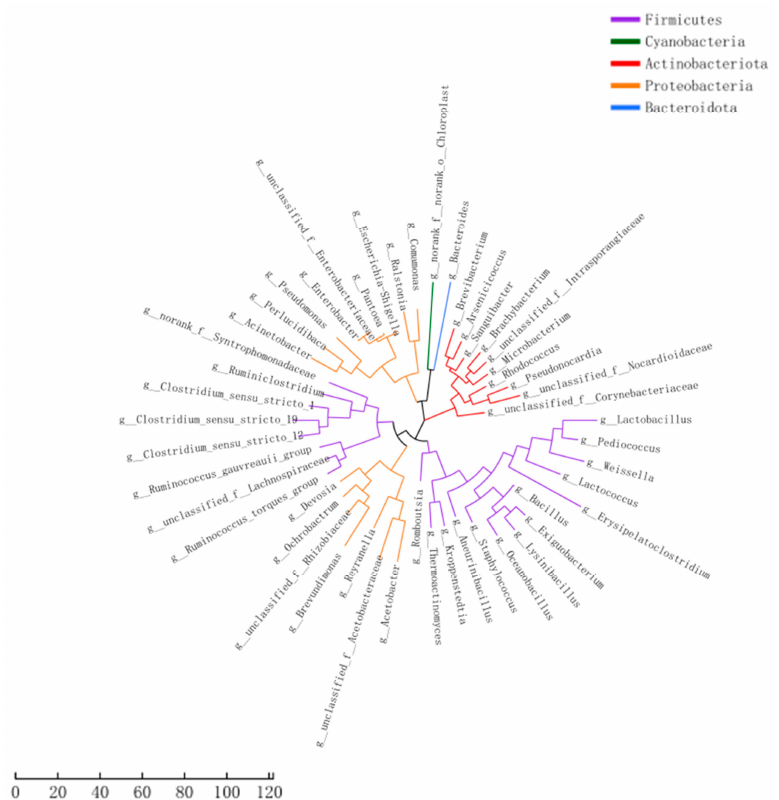
Figure 5. Phylogenetic tree of bacteria in fermented grain samples. Note: each branch corresponds to a genus detected by amplicon sequencing, and the length of the branch is the evolutionary distance between the two genera, i.e., the degree of difference between the genera.